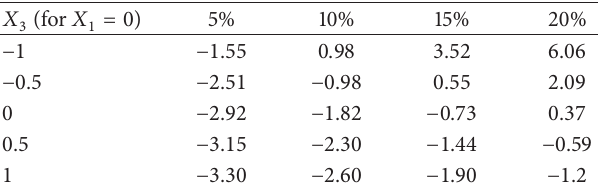
Table 4: Transformed values ( 𝑋 3 ) at various levels of 𝑋 2 for acid degradation conditions.